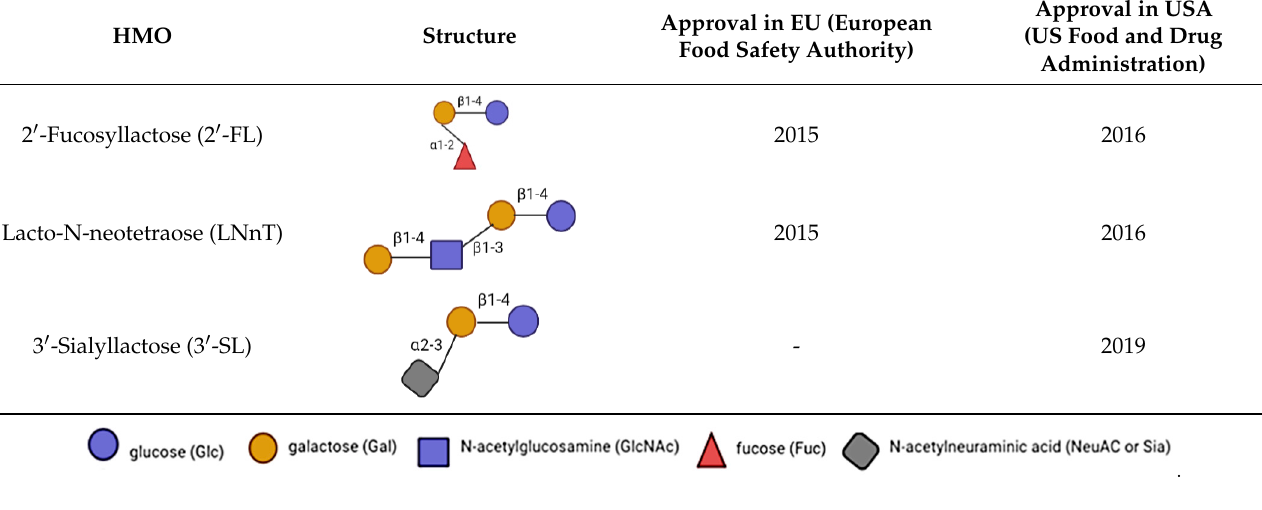
Table 4. The three HMOs approved for use in infant formula, with dates of approval by the European Food Safety Authority and the US Food and Drug Administration. HMO